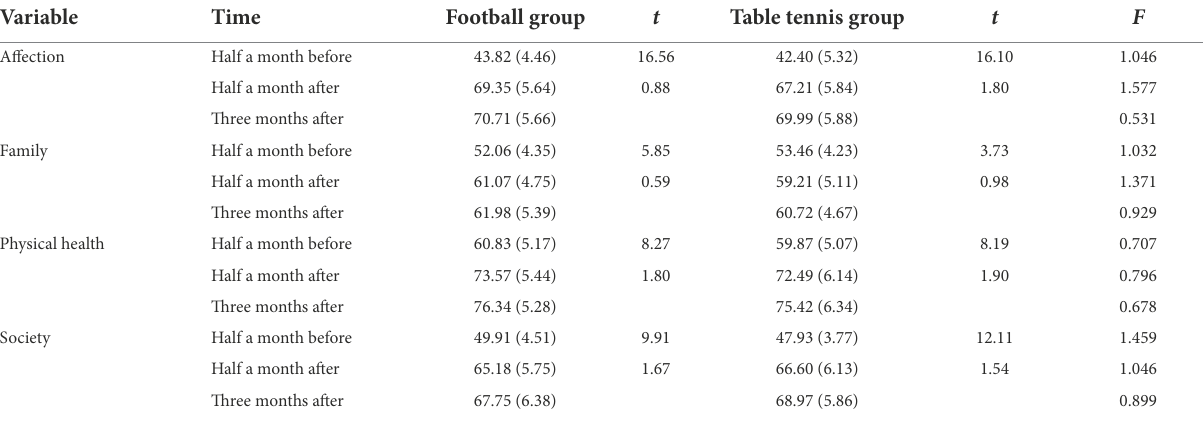
TABLE 4 The changes in self-concept of left-behind children (football group vs. table tennis). Variable Time Football group t Table tennis group t